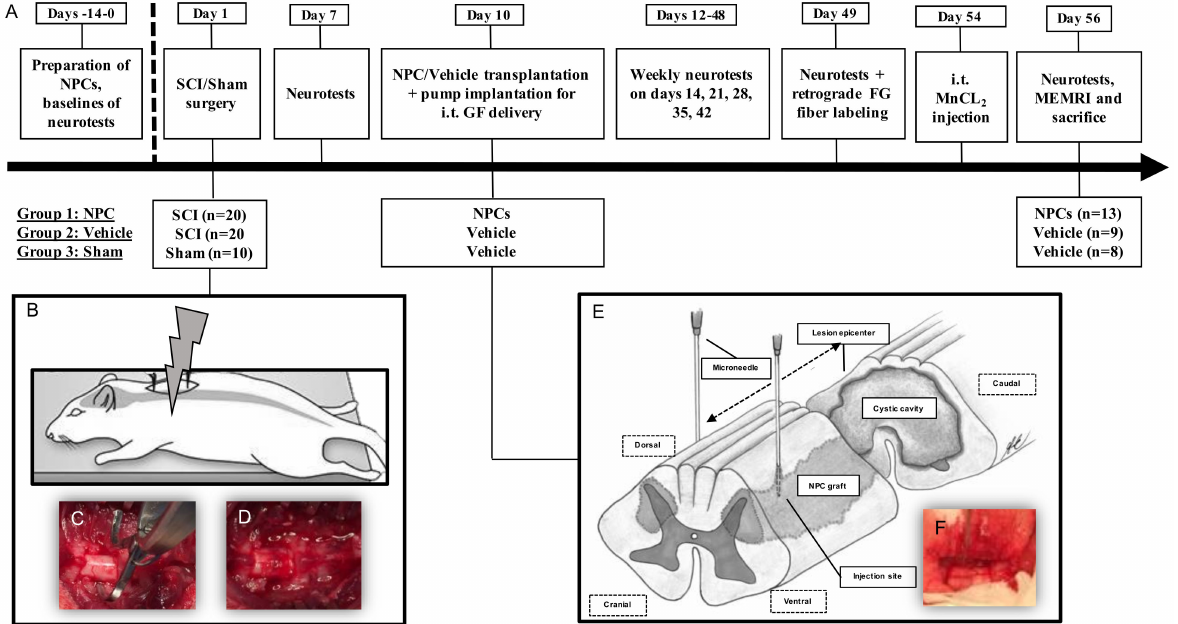
Figure 8. ( A ) Timeline of the study interventions (e.g., pump implantation for i.t. growth factor (GF) delivery at day 10 or manganese-enhanced magnetic resonance imaging (MEMRI) at day 56), also indicating the group design and the group sizes at the beginning and at the end of the experiment. ( B ) The contusion-compression SCI is performed at day 1 with a modified aneurysm clip ( C ), leaving a visible injury on the exposed cervical spinal cord at the C6 level ( D ). ( E ) Modified after (47)—NPCs are transplanted into the spinal cord at four distinct sites via stereotactic injection ( F ) at day